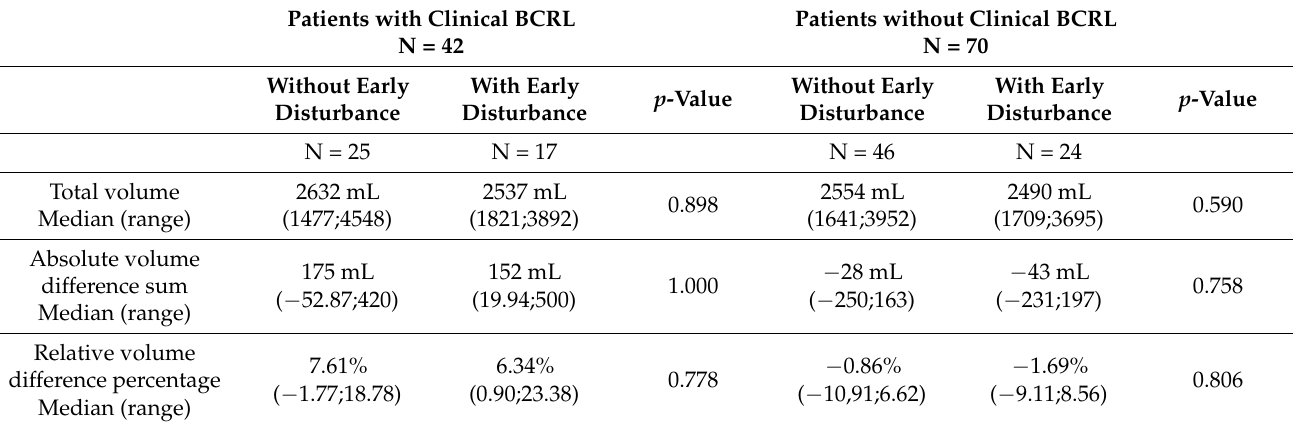
Table 2. Arm volume of affected side and absolute and relative arm volume differences for the different